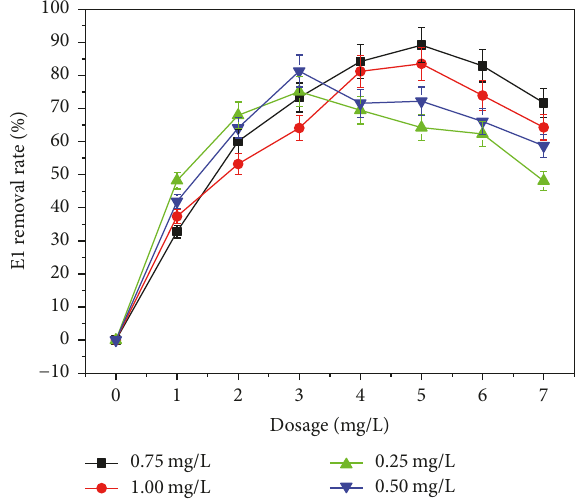
Figure 10: The effect of the E1 concentration on the flocculation performance (PADA-3 was